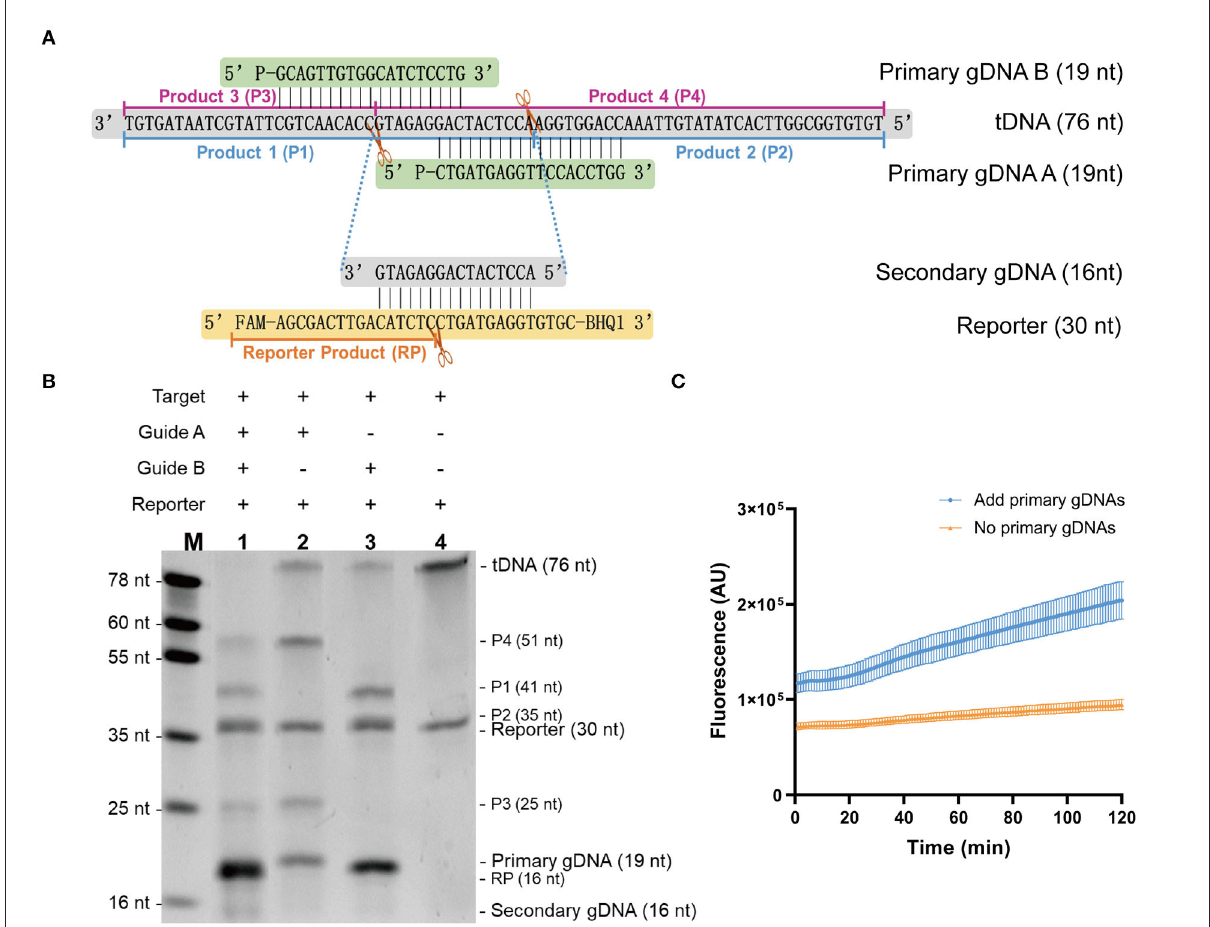
FIGURE2 Validation of the stepwise cleavage activity of mesophilic Ago. (A) Schematic diagram of Ago stepwise cleavage. (B) Gel image of Pb Ago stepwise cleavage. (C) Fluorescent result of Km Ago stepwise cleavage. Data were collected from three independent experiments and are presented as the mean ±